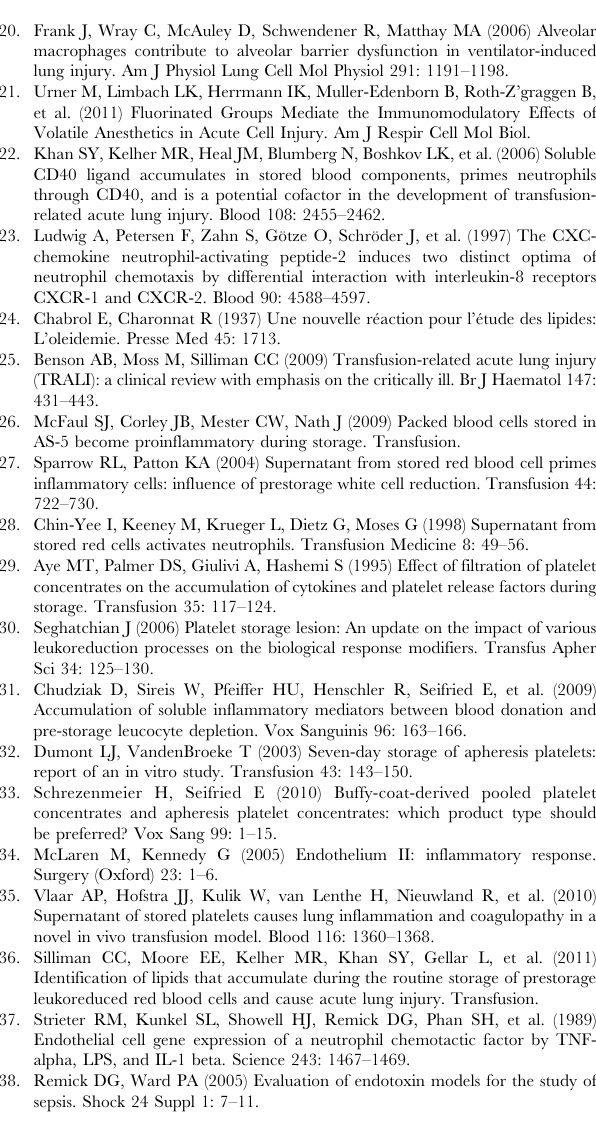
Table S4 Influence of blood product exposure on transendothe- lial migration of neutrophils. Table S5 Spearman correlations of cytokine concentrations in packed red blood cells (PRBC) and platelets concentrates (PC) versus storage age. Table S6 Spearman correlations of lipid concentration versus storage age in packed red blood cells (PRBC) and platelets concentrates (PC). Table S7 Age-dependent assessment of neutrophil transmigra- tion. Table S8 Influence of baseline sCD40L and lipid concentration in blood products on inflammatory mediator release in endothelial cells.